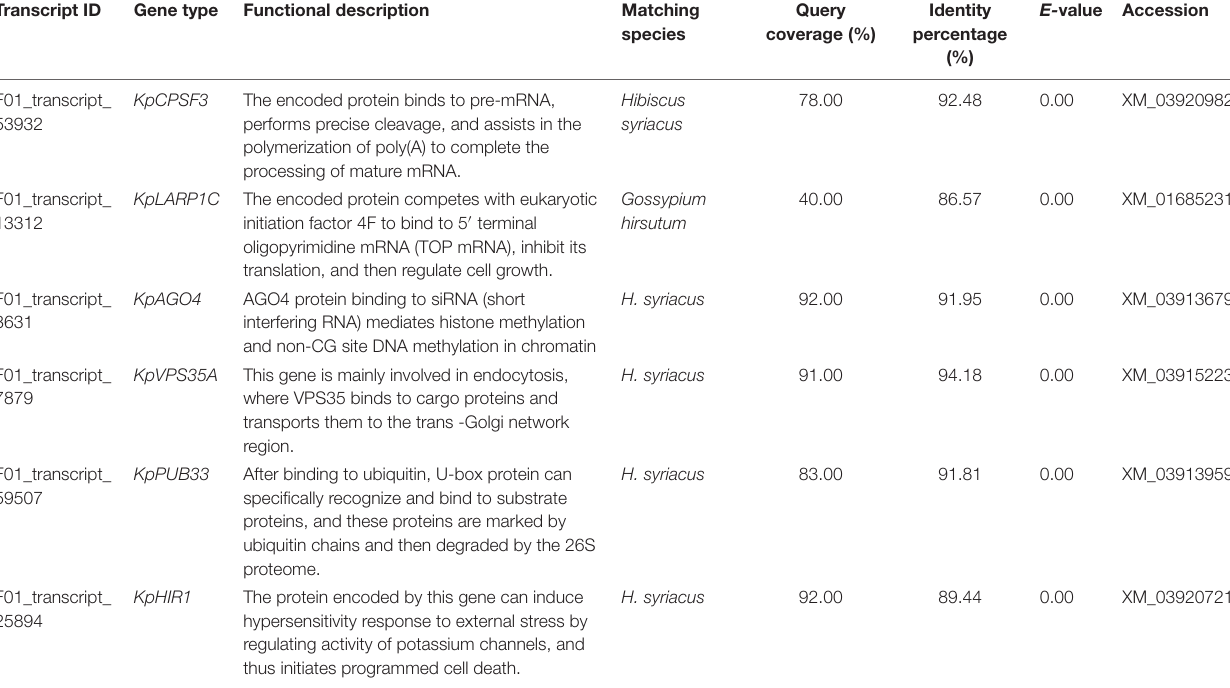
TABLE 2 | Sequence match in NCBI database and functional analysis of key differentially expressed genes in K. pentacarpos seedlings under saline–alkali stress. Transcript ID Gene type Functional